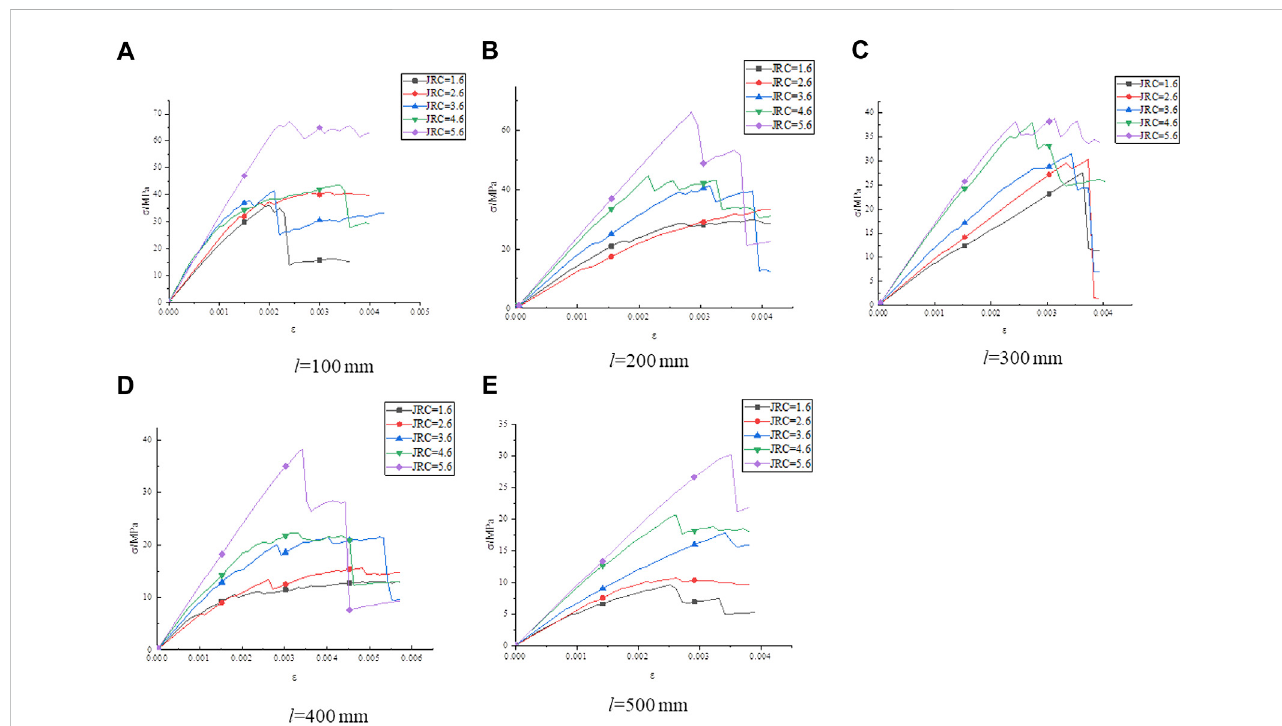
FIGURE 3 Stress strain curves of different size.